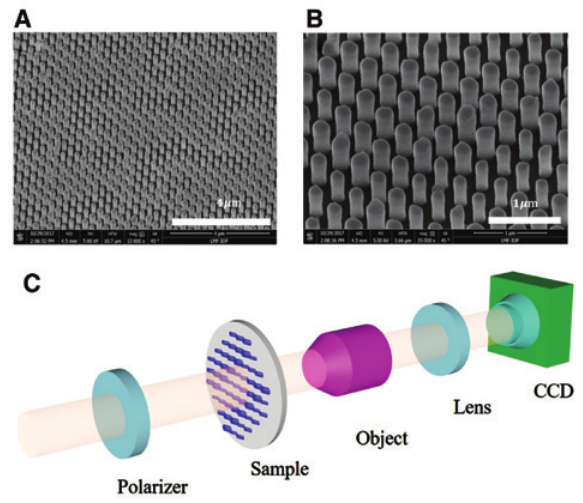
Figure 4: Sample fabrication and experimental setup. (A, B) Side view of the SEM images of the HMS. (C) Experimental setup for the characterization of